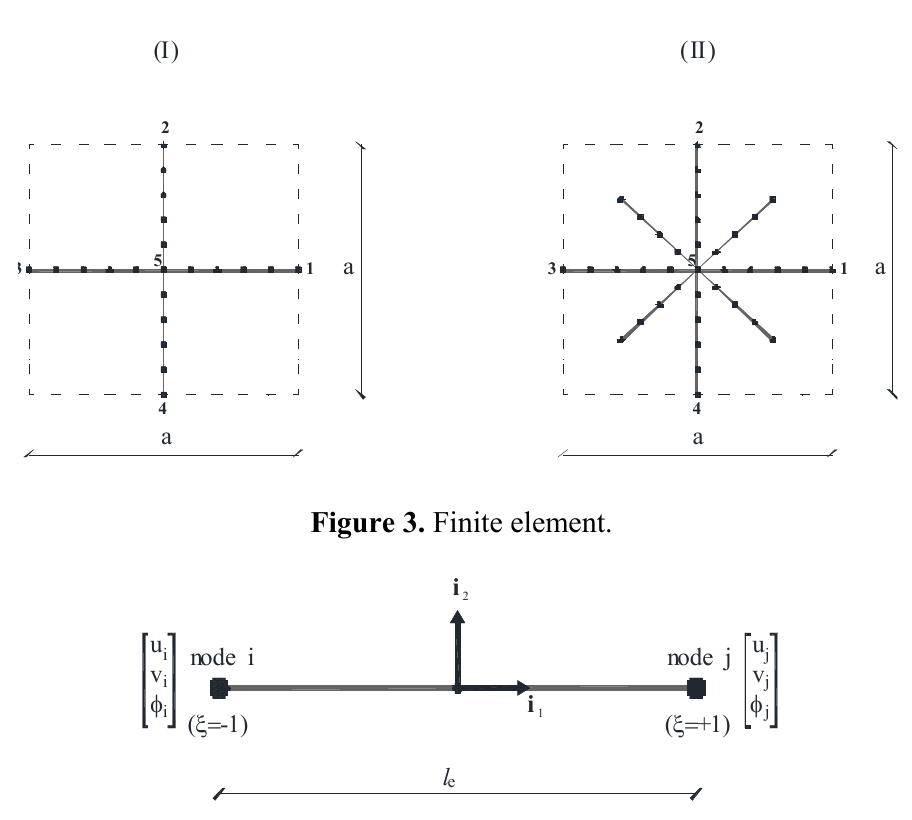
Figure 2. Examples of the FE mesh over the unit cell of a 2D square lattice material (a being the lattice constant).